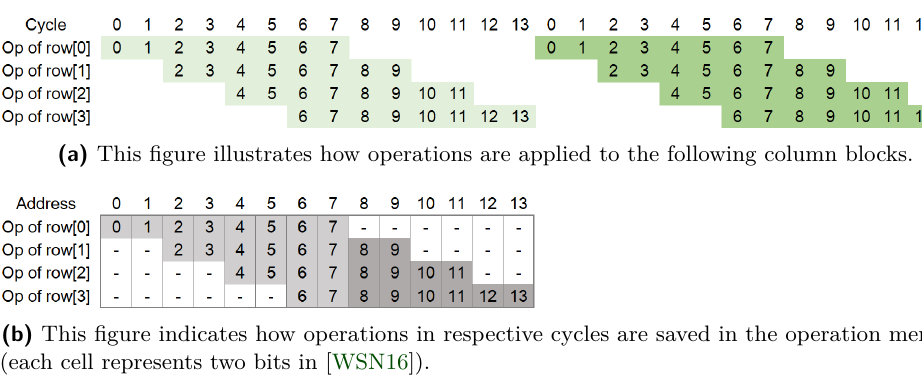
Figure 8: Details of the column-block elimination in [WSN16] for ( n − k, s ) = (8 , 4).